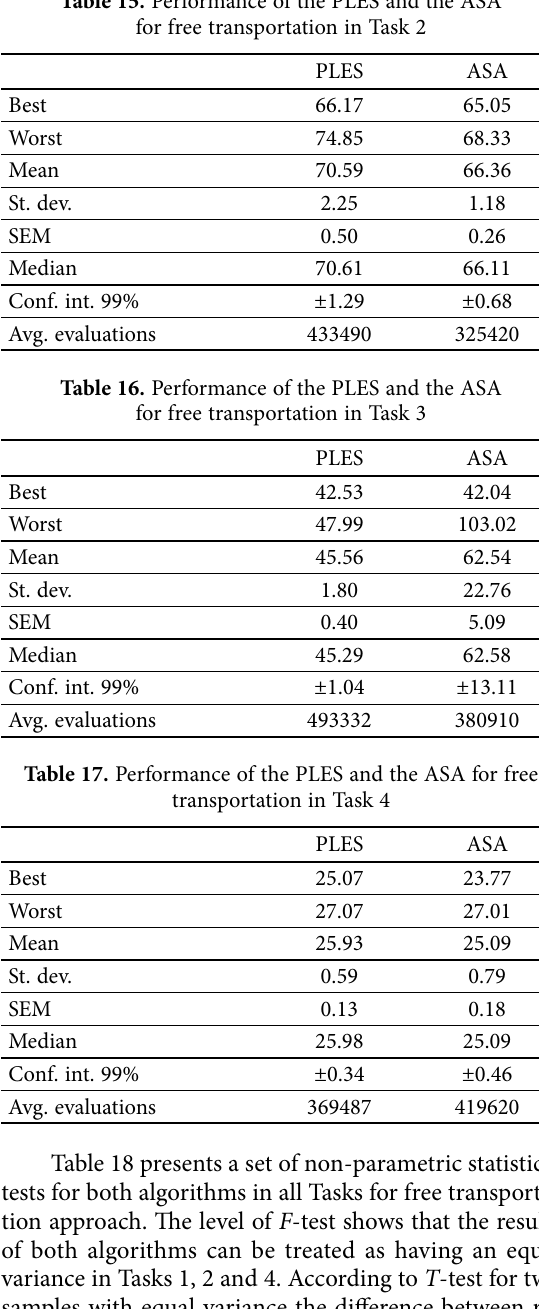
Table 15. Performance of the PLES and the ASA